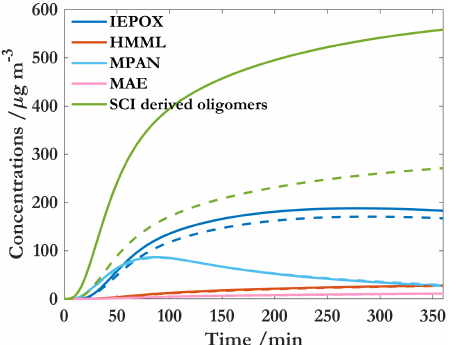
Figure 13. MCM-simulated time profiles of SOA precursors in isoprene-NO 2 irradiations. SCI-derived oligomers were from the reactions of SCIs with glyoxylic acid and ACETOL (solid lines for dry conditions, dashed lines for humid conditions).